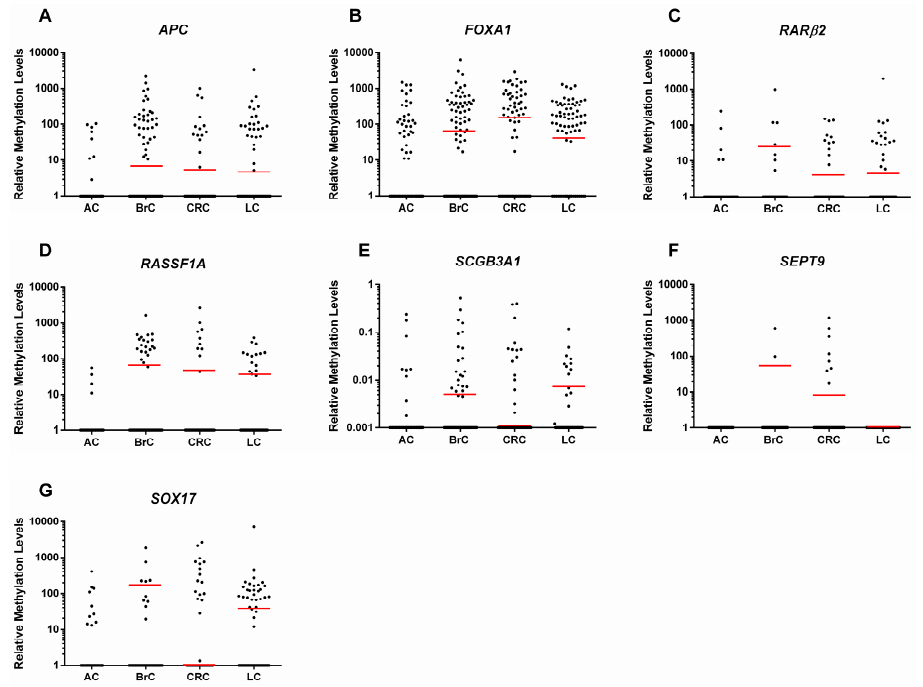
Figure 1. Scatter plot of the distribution of ( A ) APC , ( B ) FOXA1 , ( C ) RAR β 2 , ( D ) RASSF1A , ( E ) SCGB3A1 , ( F ) SEPT9 and ( G ) SOX17 relative methylation levels [(gene/ β -Actin) × 1000] of breast cancer (BrC) ( n = 108), colorectal cancer (CRC) ( n = 72), lung cancer (LC) samples ( n = 73) and asymptomatic controls (ACs) samples ( n = 103). Red horizontal lines represent cut-off values.